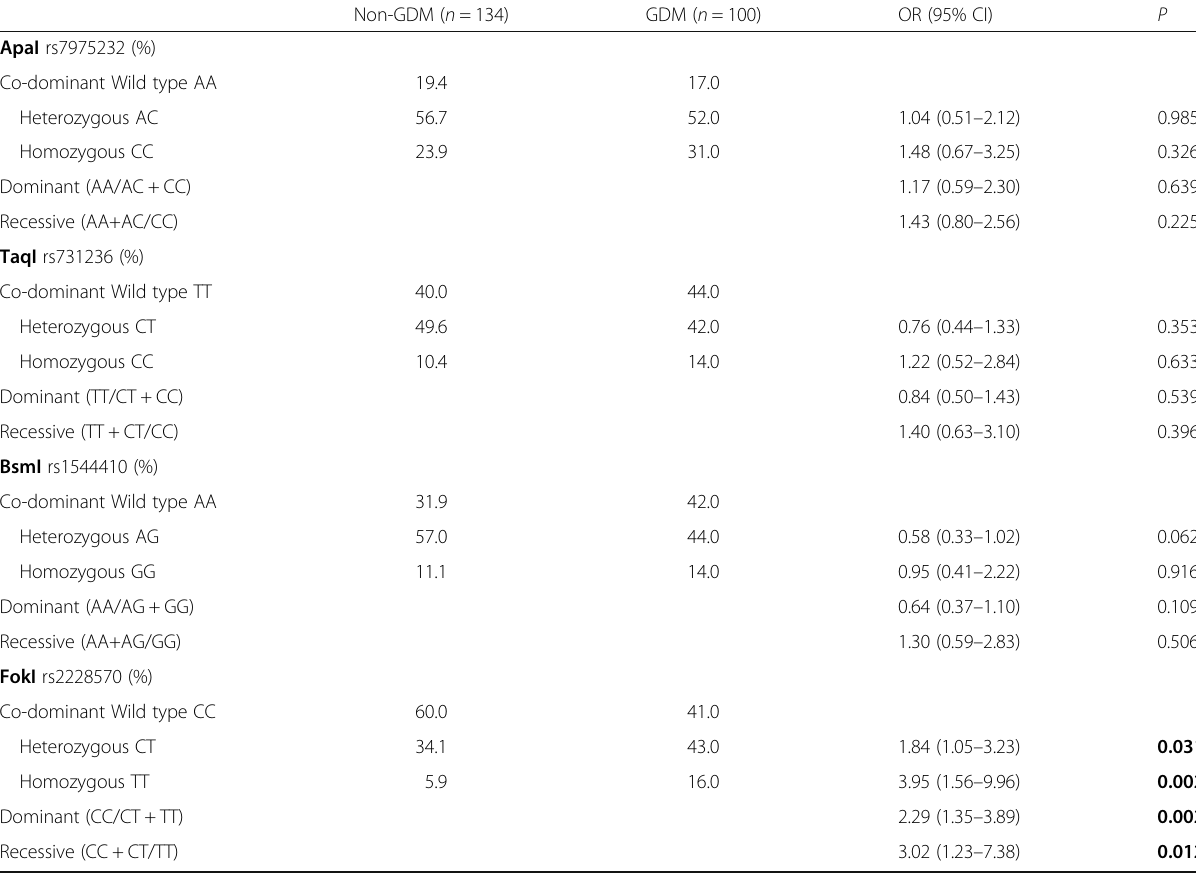
Table 3 Genotype analysis of VDR gene